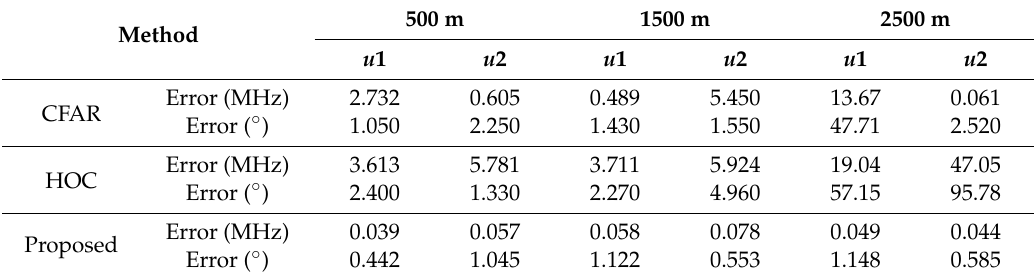
Figure 16. The results for the CFAR method for two UAVs outdoors at distances of ( a ) 500 m, ( b ) 1500 m, and ( c ) 2500 m. Table 3. Parameter estimation errors for two UAVs using three methods in an outdoor environment.